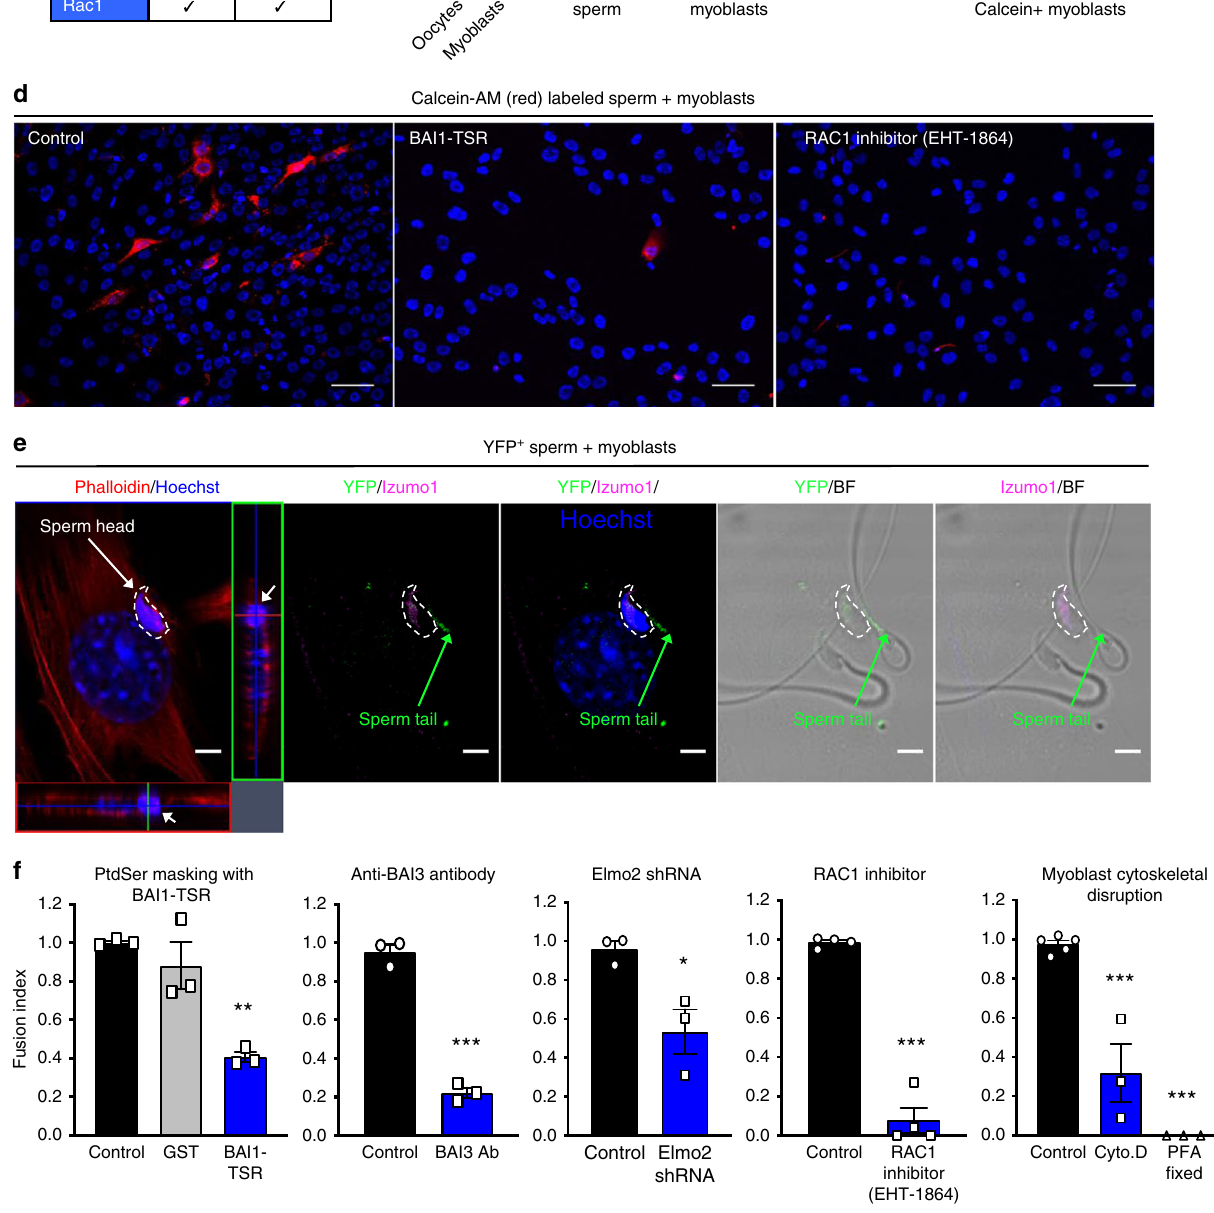
the absence of Juno. This type of combinatorial use of diverse molecules to achieve cell:cell binding/subsequent signaling is very analogous to interactions within the immune system: e.g., during T-cell interaction with an antigen-presenting cell, the central driver is the TCR:MHC/peptide interaction; yet, a host of other accessory molecules are fundamentally important for achieving speci fi city and optimal activation of T cells after antigen recog- nition. Similar to Juno (which is GPI-anchored and does not have its own signaling motif), the TCR does not have a signaling motif of its own and requires associated molecules for inducing downstream signaling and activation. Analogously, the PtdSer